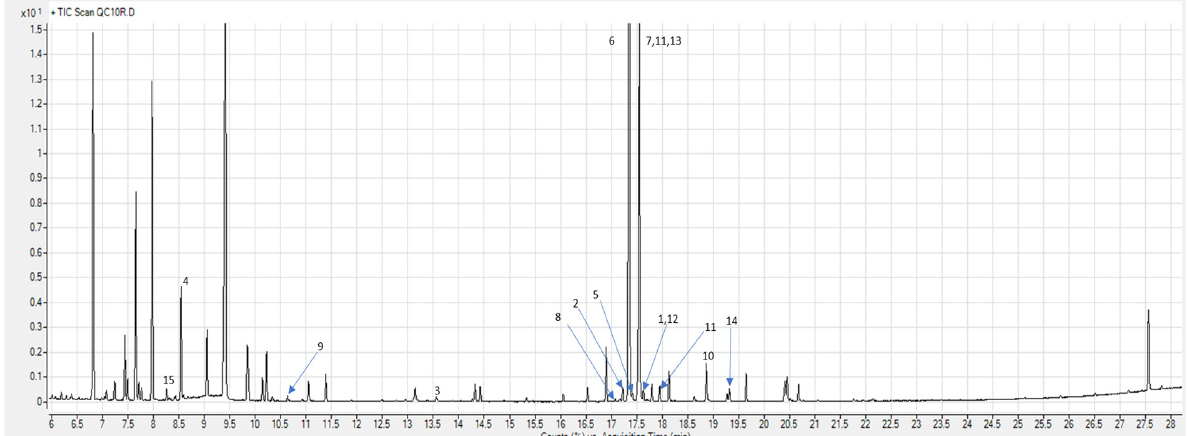
Figure 1. Total ion chromatogram (TIC) of plasma profile obtained by GC–MS with marked statistically significant metabolites. 1. Alanine, 2. Histidine, 3. Creatinine, 4. Norleucine, 5. Galactosamine, 6. Galactose, 7. Allose, 8. Fructose, 9. Glyceric acid, 10. Palmitic acid, 11. 5-Keto-D-gluconate, 12. Gluconic acid, 13. Tyramine, 14. Uric acid, 15. α -Hydroxybutyric acid. Table 2. The percentage differences in postprandial plasma metabolite levels after HC-meal intake in the PROX1 low- (LR) and high-risk (HR) genotype men. Metabolites that showed statistical significance after Wilcoxon signed-rank test. Mass found in the Human Metabolome Database (HMDB) (http://www.hmdb.caaccessed on 20 April 2021); RT, retention time expressed in minutes; p value; * p value for between-groups comparison (Mann–Whitney U test); CV, coefficient of variation of the metabolites in the QC samples; FC, fold change in the comparison. Eight individuals from the HR group participated in HC-meal. Compound Mass (DB) Molecular Formula